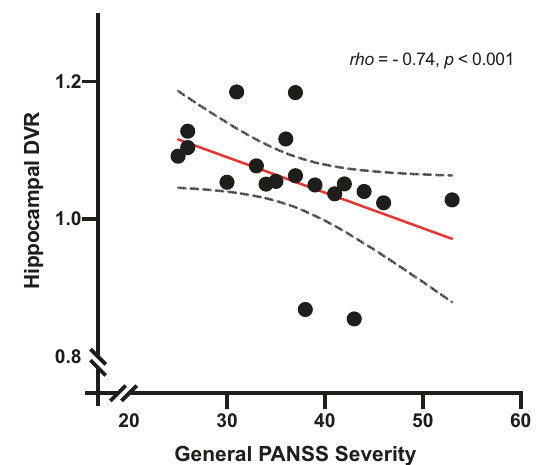
Fig. 4 Relationship of tracer uptake in the hippocampus, as measured by DVR, and General PANSS symptom severity. Dashed line represents 95%